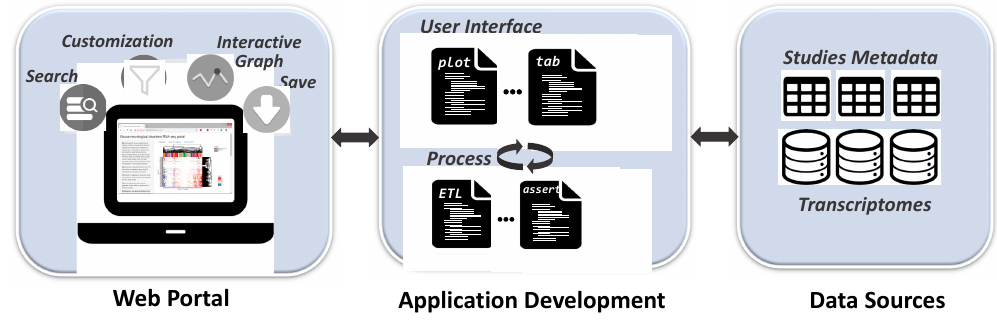
Figure 1. Infrastructure of the mouse transcriptome